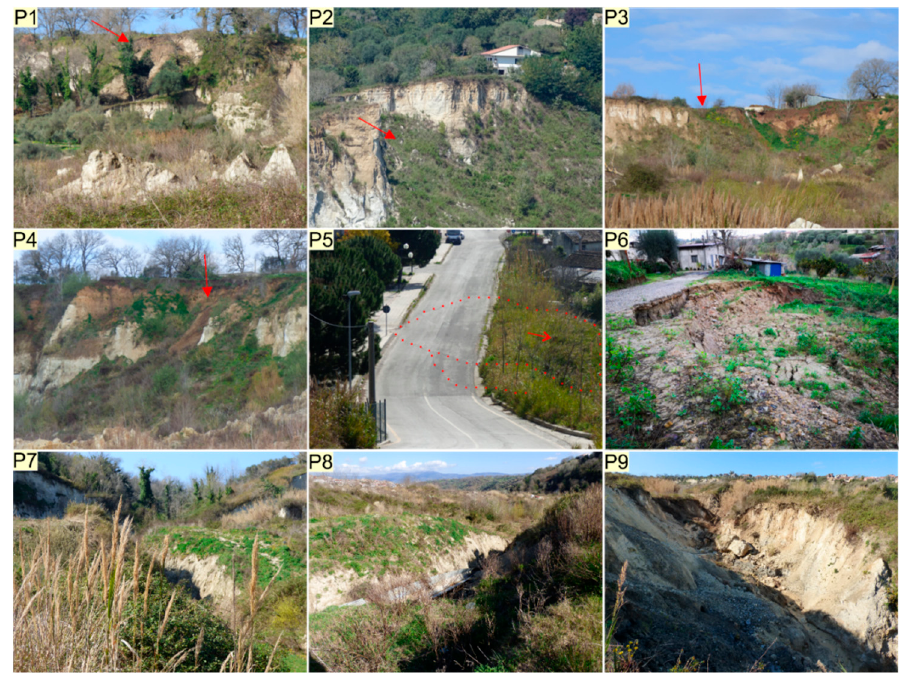
Figure 4. Photographs representing landslides (red arrows) activated in 2018 (P1–P6) and the current deepening action with local stream bank erosion along the Scotrapiti Torrent (P7–P9) (photo locations in Figure 3).